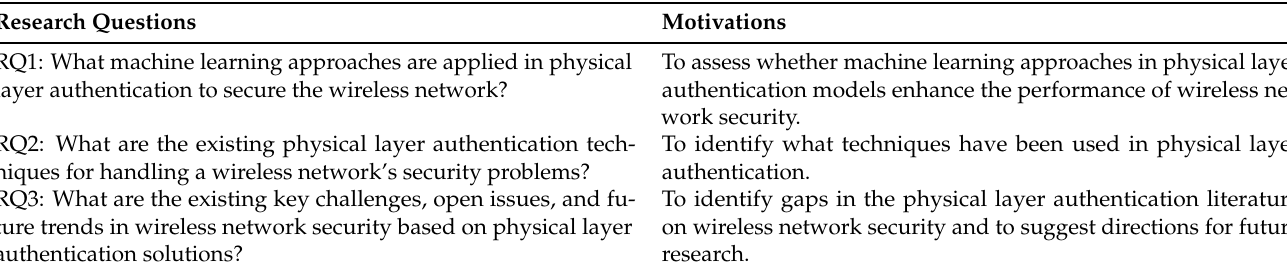
Table 2. Research questions and